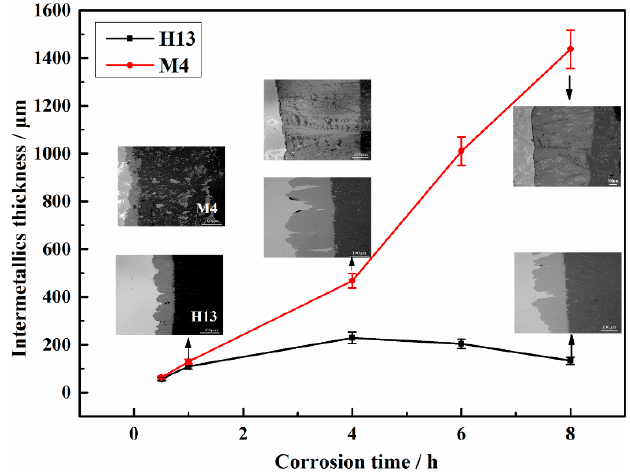
Figure 7. Relationship between the IMC thickness and the corrosion time compared with the interfacial corrosion morphologies of M4 and H13 that were corroded by molten aluminum at 750 °C.